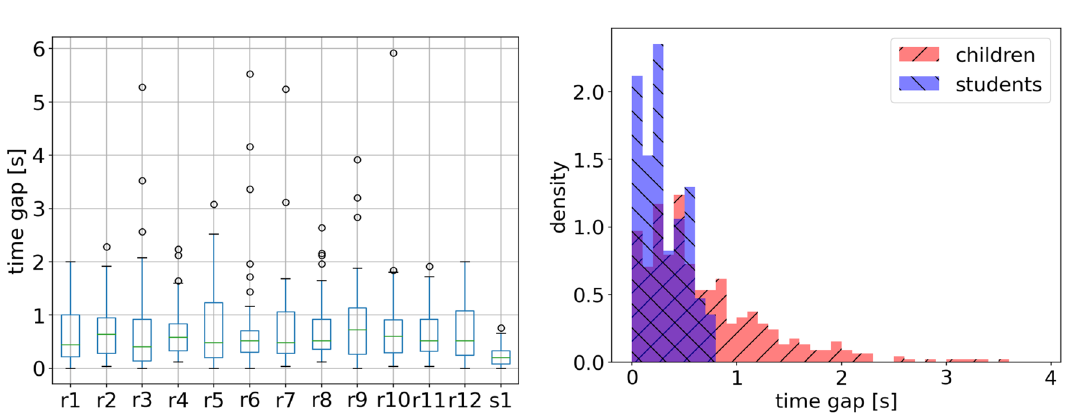
Figure 19. Distribution of time gap of children and students. Left: boxplot of data in each experimental run, r for children’s and s for students’ experiment. Right: probability density histogram, red for children, and blue for